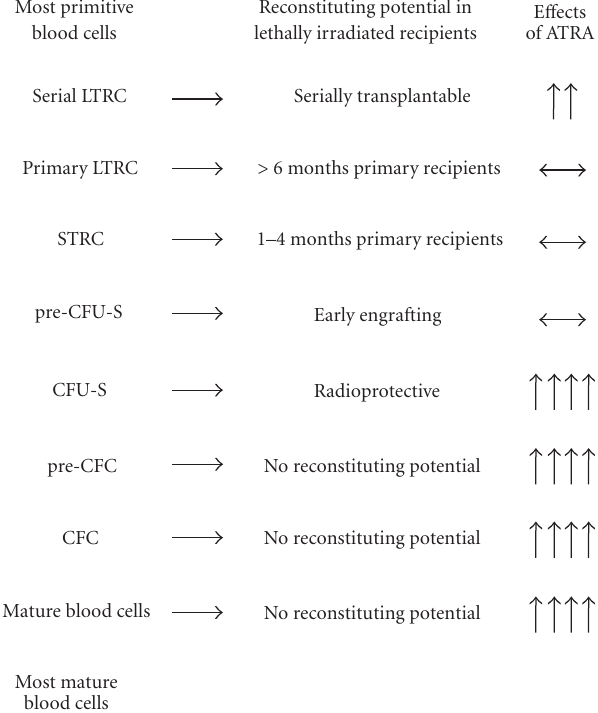
Figure 2: A summary of the e ff ects of ATRA on HSC-containing LKS+ cells. LTRC = long-term repopulating HSCs, STRC = short- term repopulating HSCs, CFU-S = colony-forming unit-spleen, CFC = colony-forming cell. Upward pointing arrows indicate in- crease in potential, the number of arrows indicates the magnitude of increase, sideways arrows indicate maintenance of potential. Modi- fied from